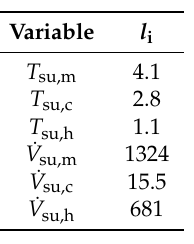
Table 2. Optimal length-scales for a six-input